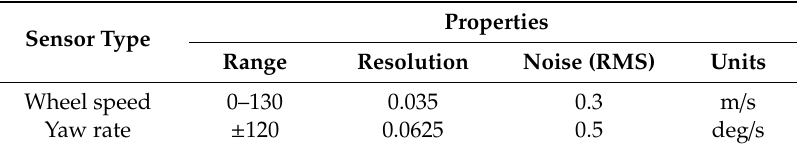
Figure 3. Environment sensor configuration of the test vehicle. Table 1. Noise specifications of proprioceptive